Question: What type of chart is this?
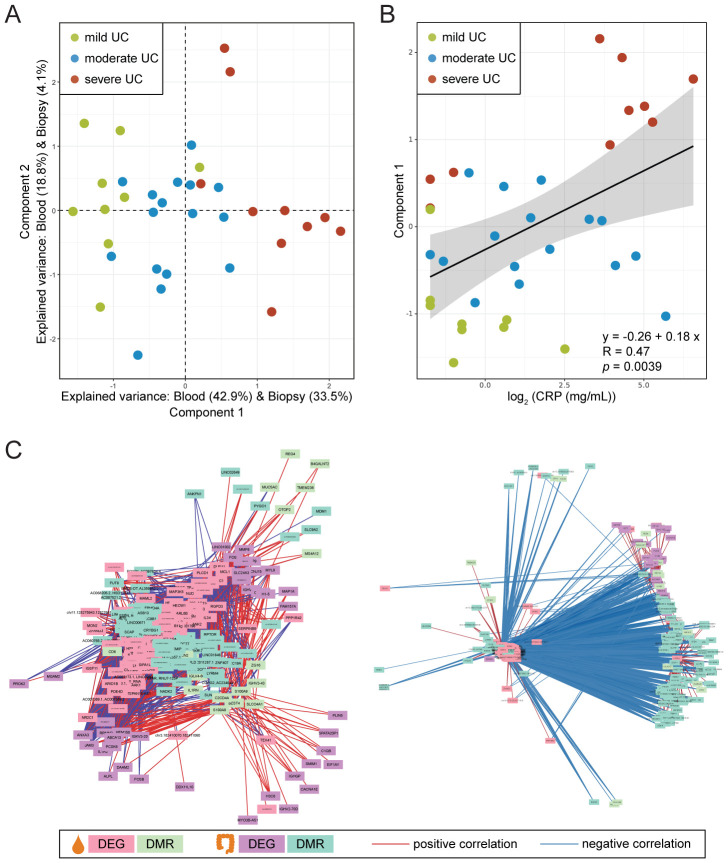
Answer: scatter